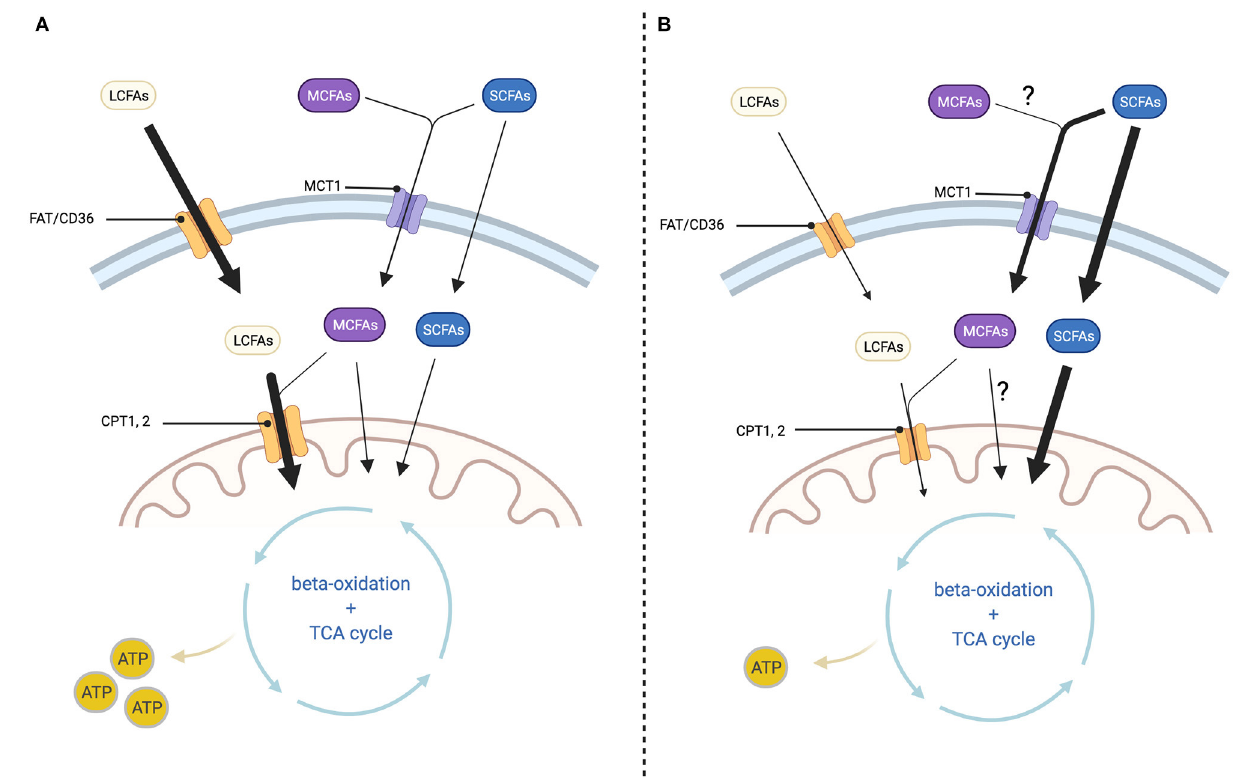
FIGURE 2 | Cellular fatty acid transport depending on chain length and changes in HF. (A) In healthy myocardium: Long-chain fatty acids (LCFAs) enter the cell via fatty acid translocase (FAT/CD36) and the mitochondrion via the carnitine shuttle (CPT1, 2). Medium-chain fatty acids (MCFAs) enter the cell via monocarboxylate transporter 1 (MCT1) and the mitochondrion via CPT1, 2 or transporter independent. Short-chain fatty acids (SCFAs) enter the cell via monocarboxylate transporter 1 (MCT1) or through transporter-independent mechanisms. Passage across the mitochondrial membrane is as well-transporter-independent. Inside the mitochondrion both LCFAs, MCFAs and SCFAs are processed through beta-oxidation and the TCA cycle for ATP-generation. (B) In diseased myocardium: LCFA uptake into the cell and mitochondrion is decreased at least in part because the expression of FAT/CD36 and CPT1, 2 are diminished. On the other hand, SCFA uptake into the cell as well as the mitochondrion is increased, but this is not sufficient to prevent a reduction in ATP production. Changes in MCFA oxidation are not well-described. Created with